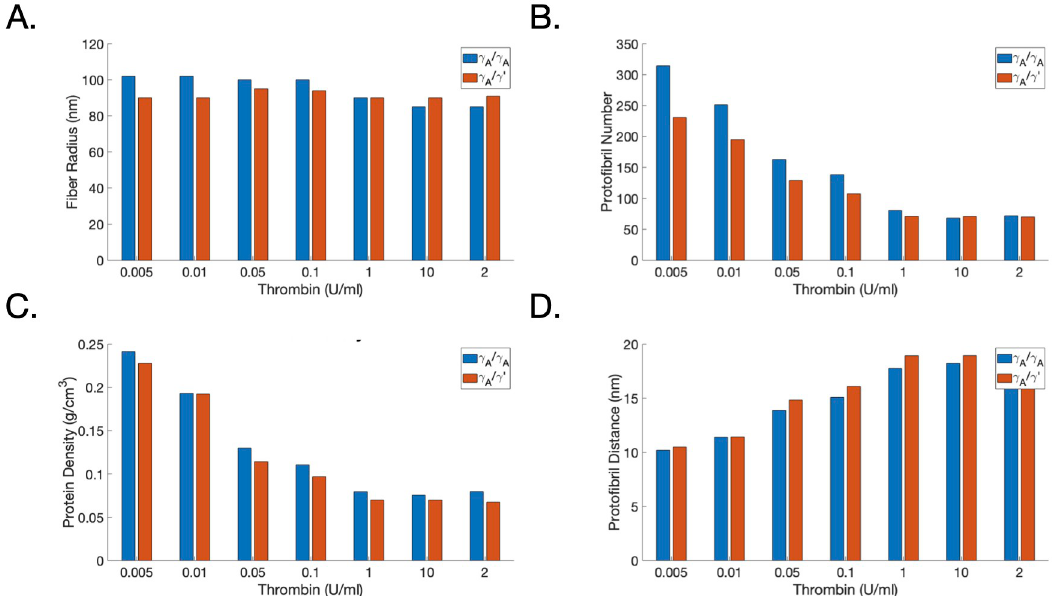
Fig 5. Box plot of parameter estimates and relative clot time vs. fibrinogen. Left: Box and whisker plot for 300 parameter sets with the smallest least squares errors from the parameter estimation process. The parameter values are shown in log-scale and the units are those in Table 2. Right: The ratio of clot times showing the relative clot time between γ defined as the time to half-maximal turbidity measurement. The model output (solid line) is below the experimental data from Kim et al. [38] (dots with error